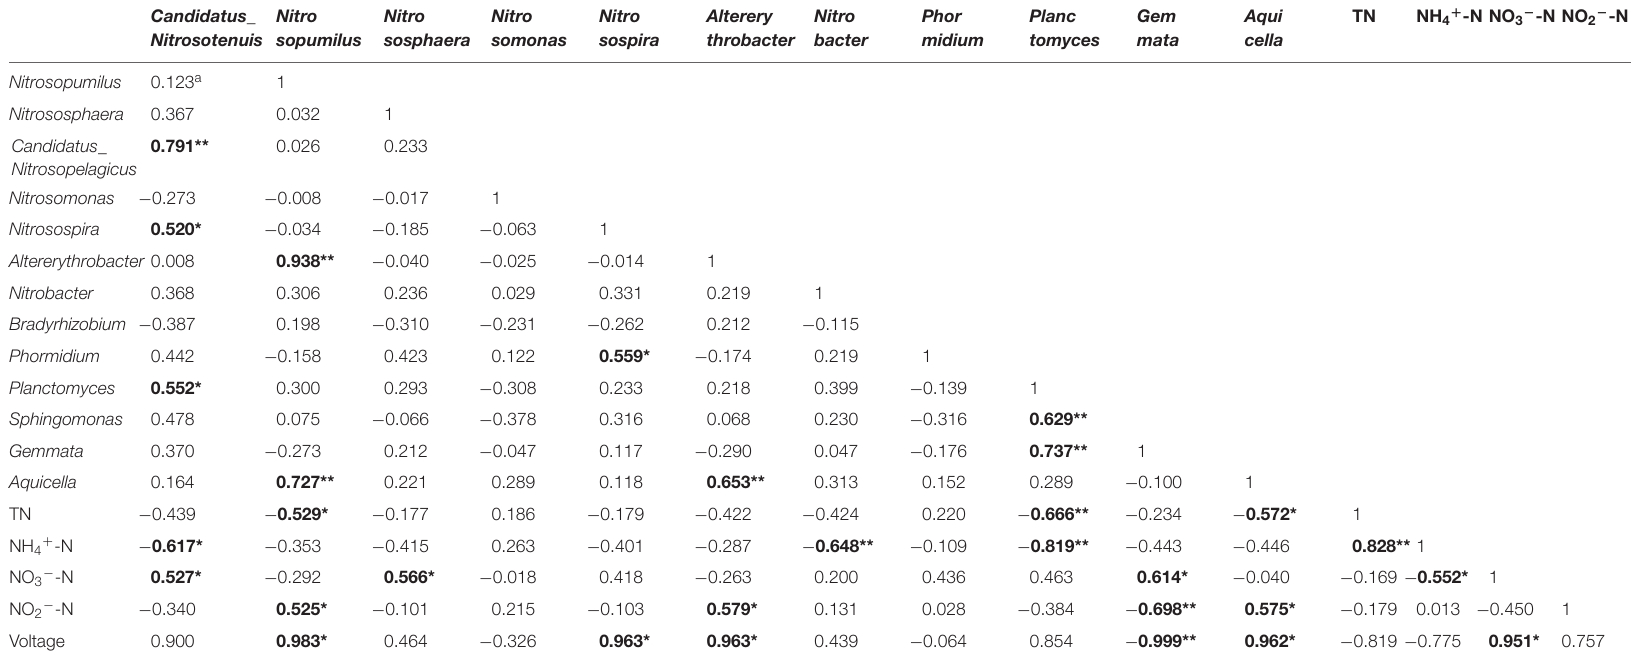
TABLE 4 | Pearson correlation between dominant genera of each of the four types of microorganisms, voltage, and effluent nitrogen concentration ( n = 16). Candidatus_ Nitro Nitro Nitro Nitro Nitrosotenuis sopumilus sosphaera somonas